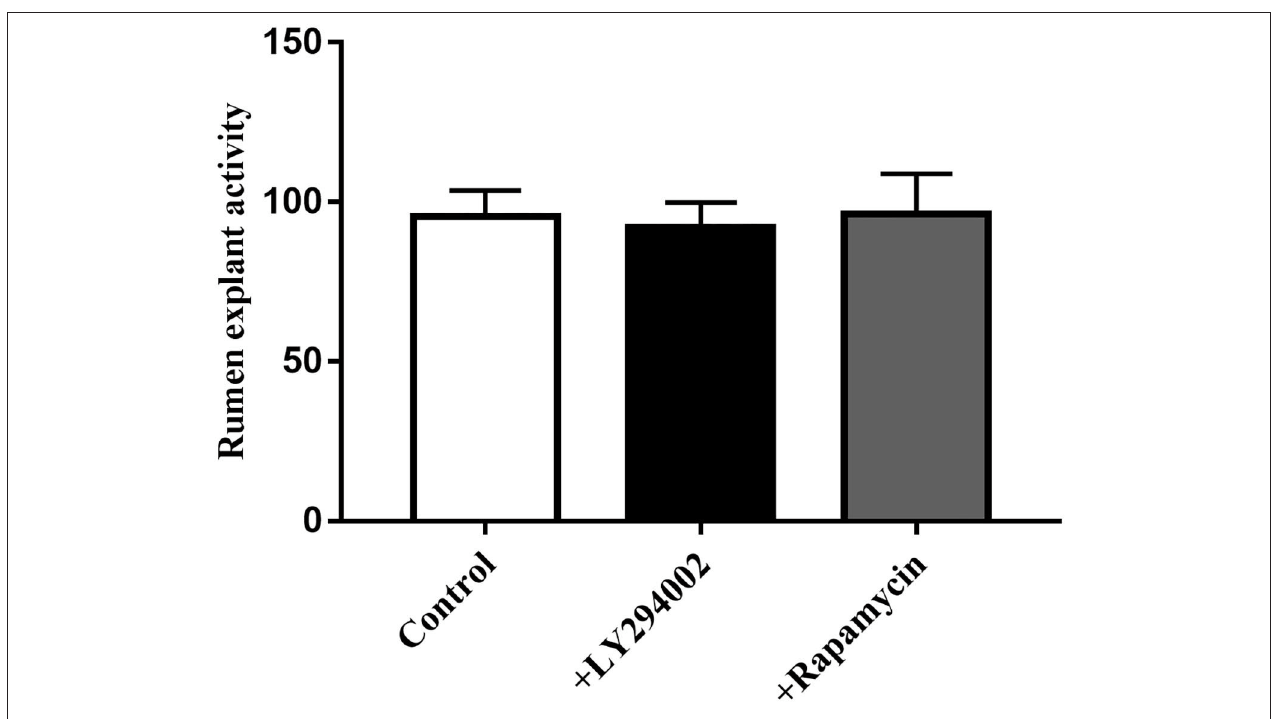
FIGURE 10 | Effect of LY294002 and Rapamycin on the cell activity of rumen explants was determined by MTT. The MTT data indicated that the addition of LY294002 or Rapamycin did not affect viability or had toxic effects on rumen explants. One-way ANOVA in SPSS 22.0 software was used to analyze the data, presented as mean ±